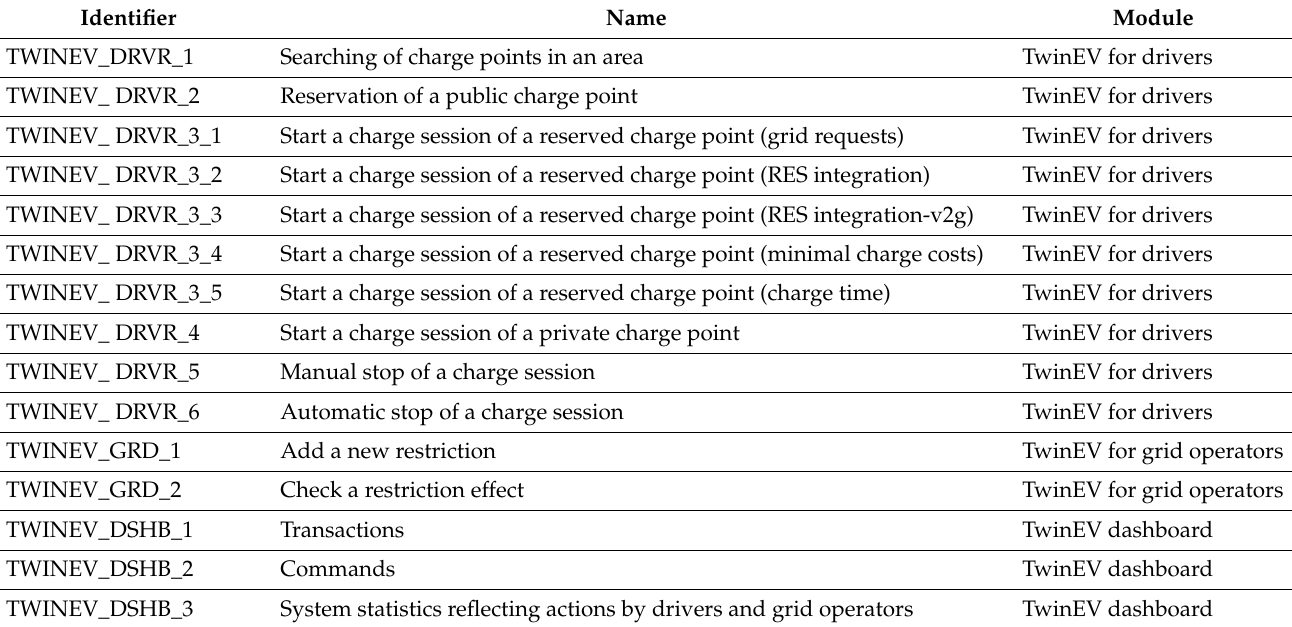
Table 4. List of test